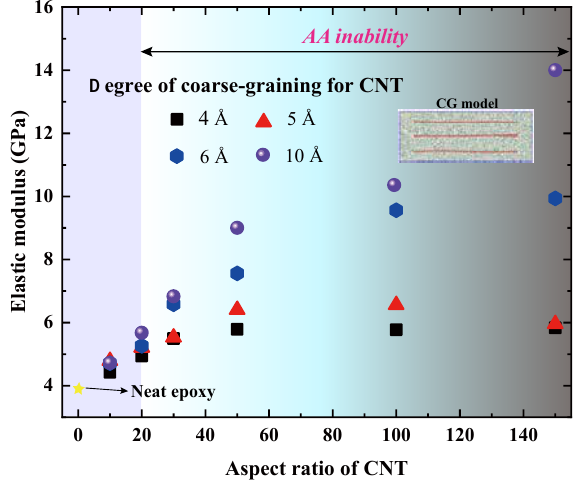
Figure 8. Axial elastic moduli of epoxy-matrix nanocomposites reinforced by the CNTs which have different aspect ratios and various degrees of